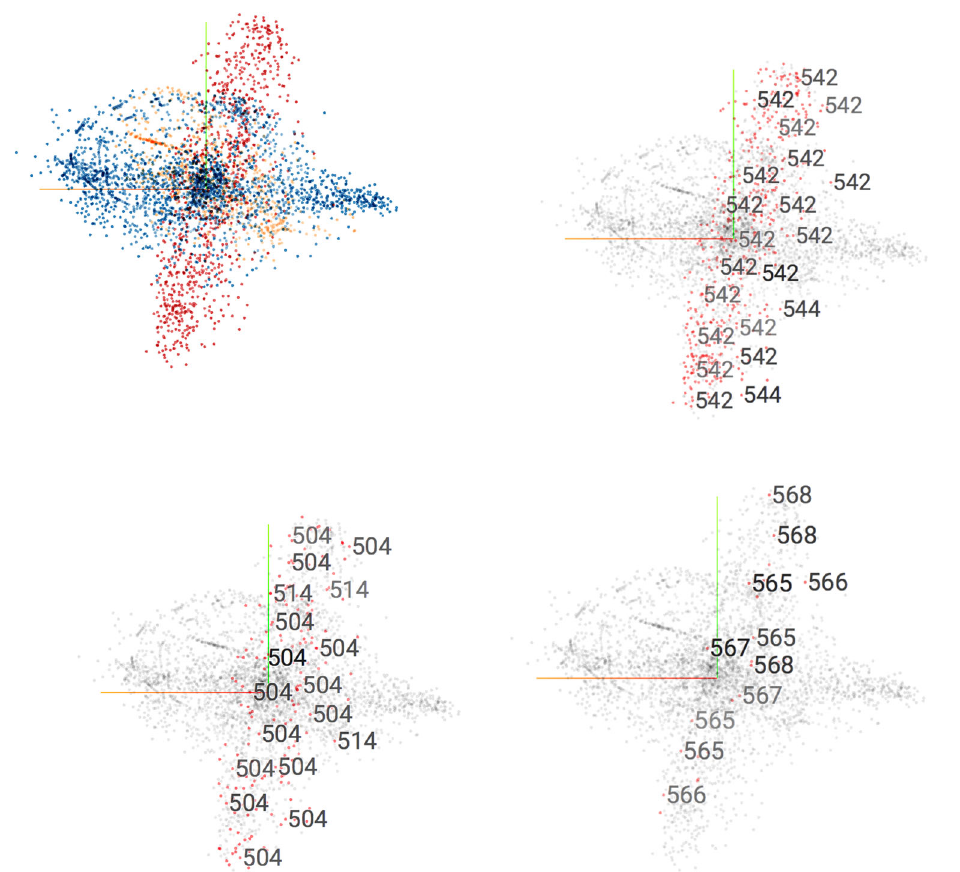
Fig. 4 Projections obtained with TFEP, where principal components 3, 5 and 8 have been selected, and the view was rotated such that the jet+ t ¯ t cluster is roughly orthogonal to the DIS cluster. The top left plot